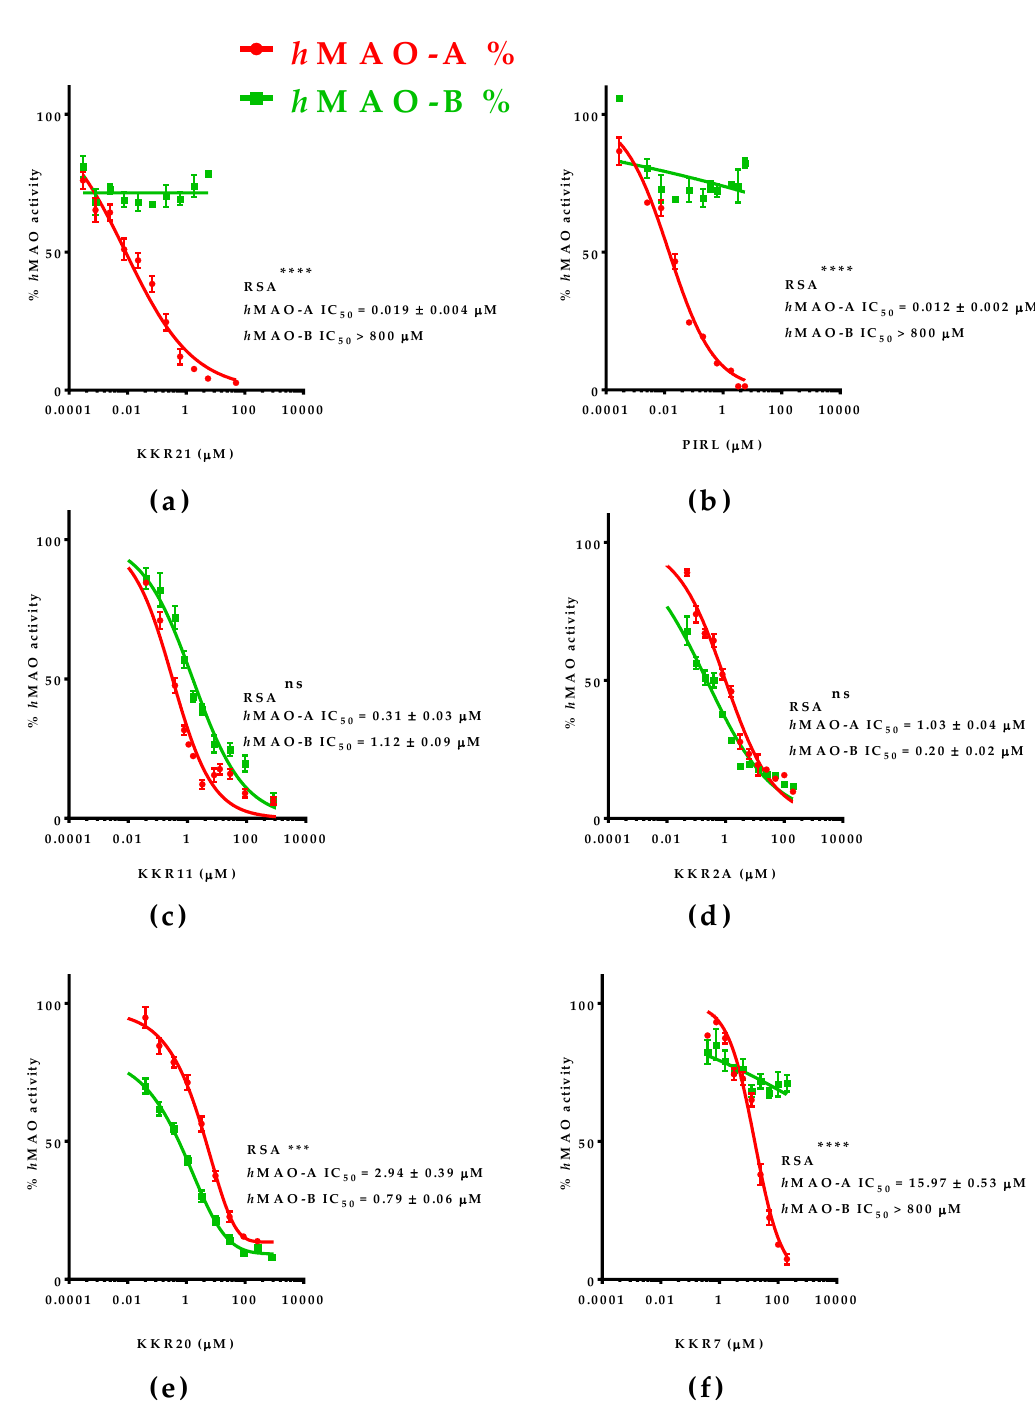
Figure 2. KKR h MAO-A and h MAO-B inhibitory potencies and h MAO-A relative selectivity (RS A ); ( a ) KKR21, ( b ) standard PIRL, ( c ) KKR11, ( d ) KKR2A, ( e ) KKR20, and ( f ) KKR7. All compounds were equally potent MAO-AIs with different RS A . The percent points were presented as the mean ± SEM, n ≥ 4. The IC 50 ± SEM values were averaged from at least two experiments. Significance of difference between the two isozymes IC 50 s for each compound was determined using two-way ANOVA, followed by Sidak’s multiple comparisons tests. ns p > 0.05, *** p < 0.001, **** p < 0.0001.